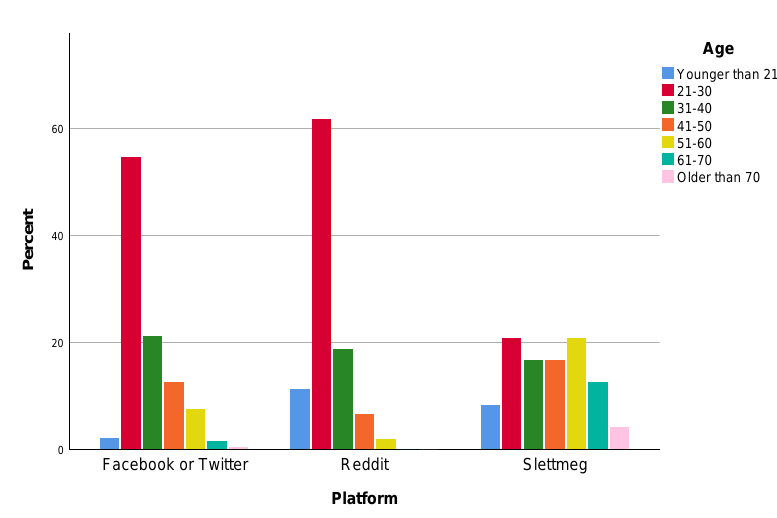
Figure 1. Comparison of age distributions, in %, for the different social